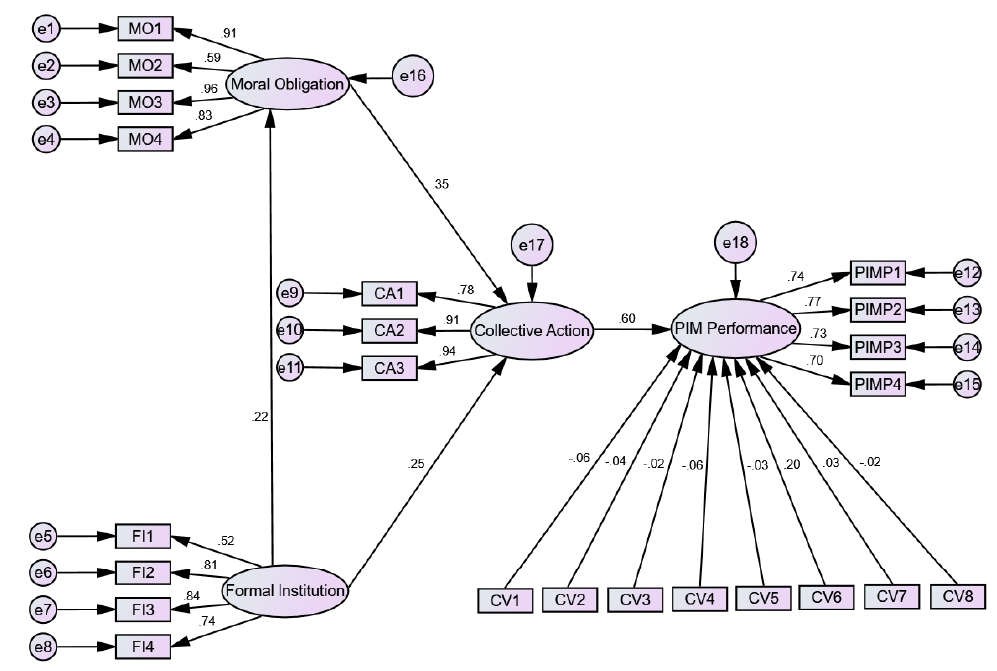
Figure 3. The SEM of moral obligation and formal institution affecting PIM performance.